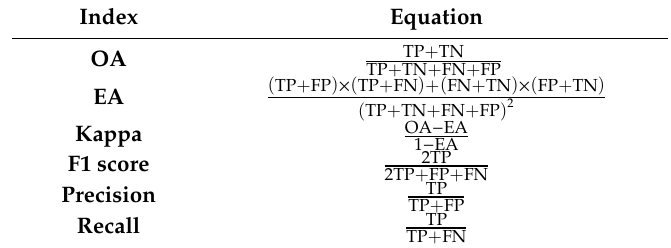
Table 2. Accuracy indices calculated for each classifier. TP is the number of the irrigated plots truly classified as irrigated, TN is the number non-irrigated plots truly classified as non-irrigated plots, FP is the number of non-irrigated plots falsely classified as irrigated, FN is the number of irrigated plots falsely classified as non-irrigated plots, N is the total number of plots, and EA is the expected accuracy.